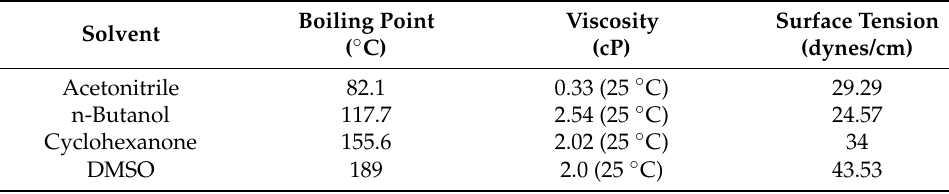
Figure 3. AFM images of PMA thin films with various solvents. Table 1. Boiling point, viscosity, and surface tension of the solvents used. Table 1. Boiling point, viscosity, and surface tension of the solvents used.